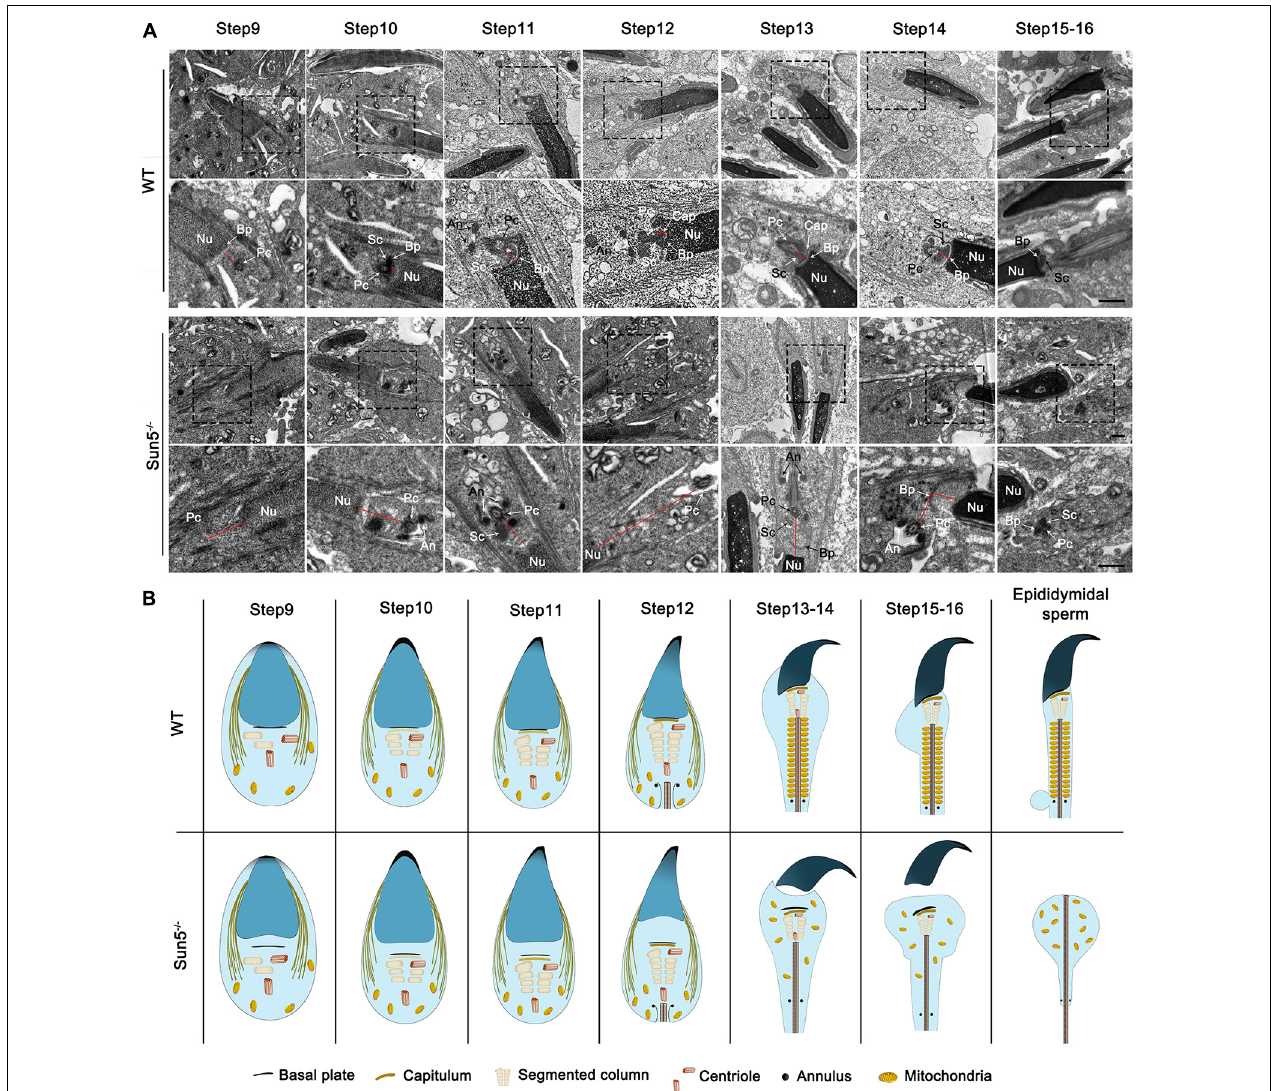
FIGURE 4 | Stepwise development of the centrosome and HTCA in WT and Sun5 − / − mice. (A) The ultrastructure of steps 9–16 spermatids in WT and Sun5 − / − mice by TEM. In step 9 spermatids, the proximal centriole (Pc) appeared at the caudal side of the nucleus (Nu) and gradually assembled the structure of the HTCA. The spacing between the proximal centriole and nucleus increased in Sun5 − / − mice compared with WT mice. In subsequent development, the formation of the capitulum (Cap), segmented column (Sc) and annulus (An) was observed in both WT and Sun5 − / − mice. However, the HTCA could not attach to the nuclear envelope tightly in Sun5 − / − mice. The complete removal of the spermatozoa head from the flagellum occurred during the step 14 manchette disappearance stage. The red line represents the distance between the nuclear membrane and the centrosome. Bars: 2 µ m (above) and 1 µ m (below). (B) Schematic representation of the stepwise development of the centrosome and HTCA in WT and Sun5 − / − mice based on